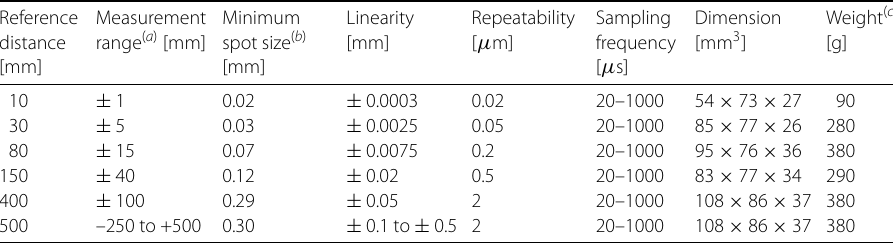
Table 1 Performance parameters of selected triangular laser heads (Source: https://www.keyence.co.uk/products/measure/laser-1d/lk-g3000/models/) Reference